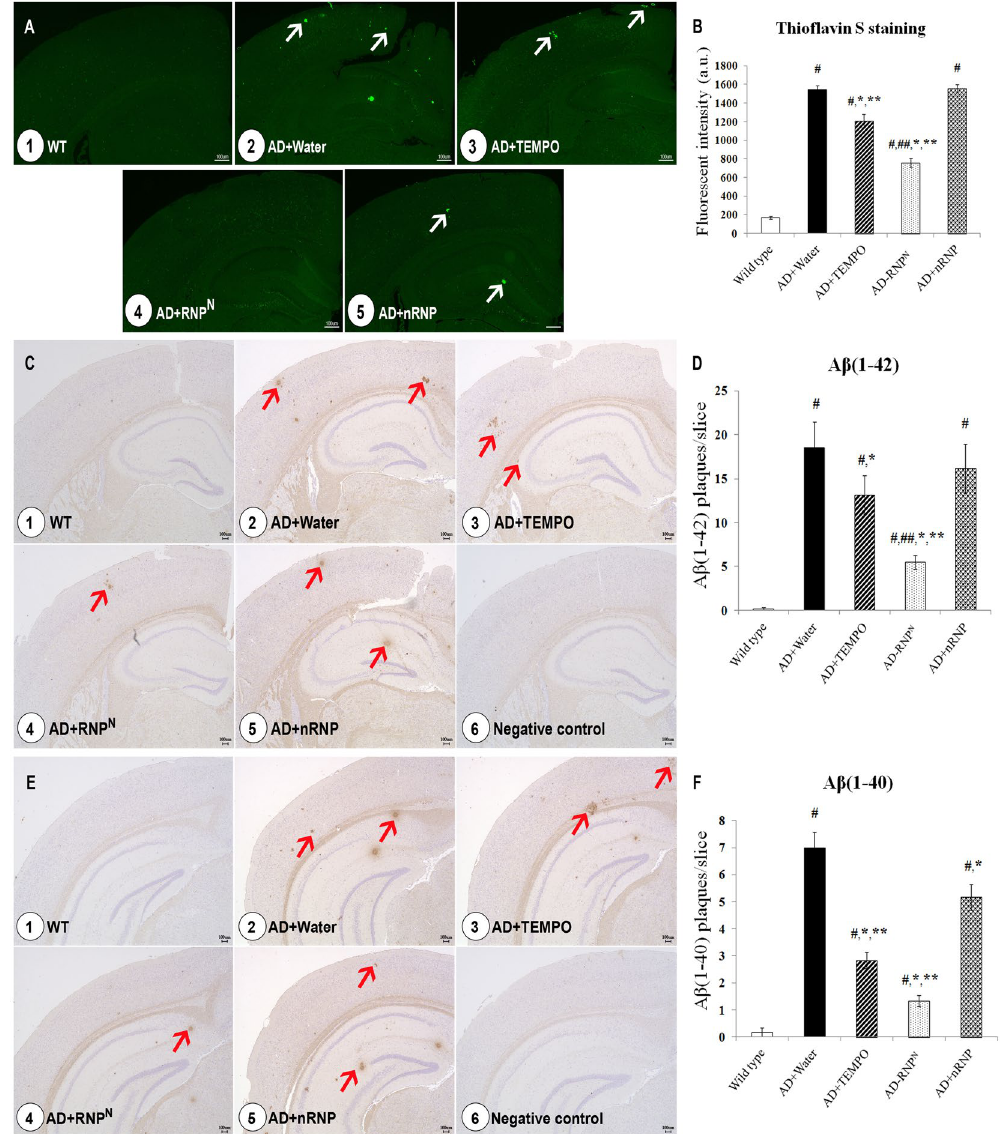
Figure 5. The effect of oral ad libitum drinking of RNP N on A β -fibrils using thioflavin S staining ( A ), semi- quantitative analysis of A β -fibril ( B ), immunohistochemistry staining of A β (1-42) ( C ), semi-quantitative analysis of A β (1-42) ( D ), immunohistochemistry staining of A β (1-40) ( E ), and semi-quantitative analysis of A β (1-40) ( F ) of the cerebral cortex of mice brain; 1. wild type group; 2. AD mice group treated with water; 3. AD mice group treated with TEMPO; 4. AD mice group treated with RNP N ; 5. AD mice group treated with nRNP; 6. negative control group. Data were expressed as mean ± SEM, # vs. wild-type group, p < 0.05; ## vs. AD mice treated with TEMPO, p < 0.05; * vs. AD mice treated with water, p < 0.05; ** vs. AD mice treated with nRNP, p < 0.05, n = 5 sample/group. White arrow indicates amyloid fibril and red arrow indicates amyloid plaque and scale bar = 100 μ